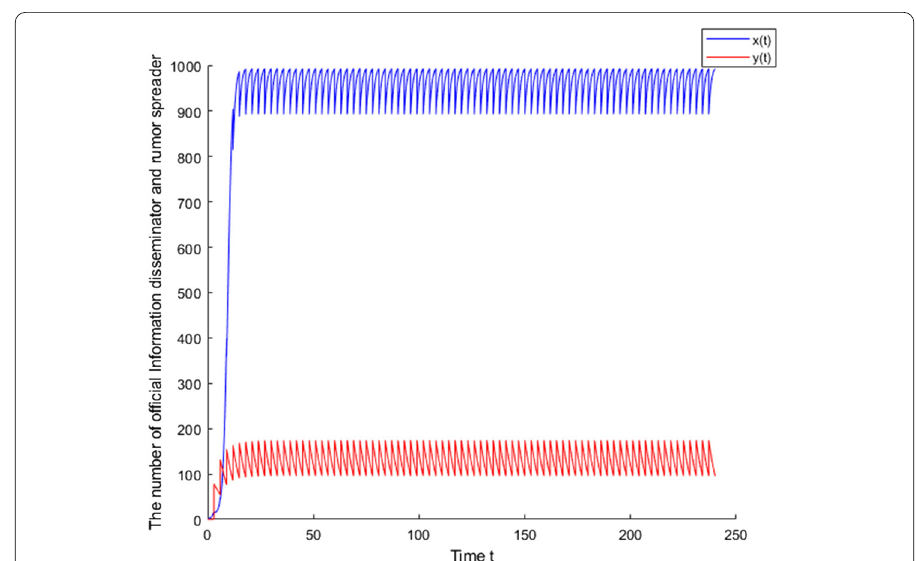
Figure 2 Time-series of the spreader x and the disseminator y for permanence